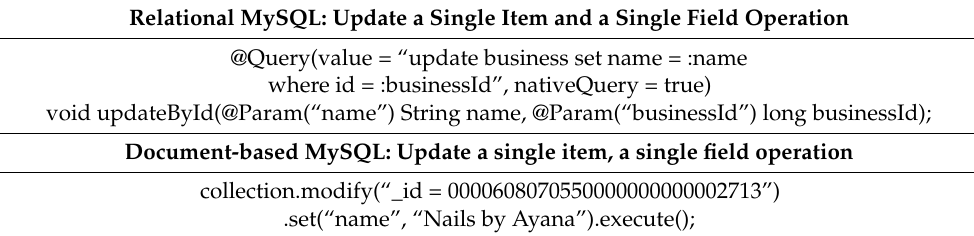
Table 4. Update a single item and a single field operation.